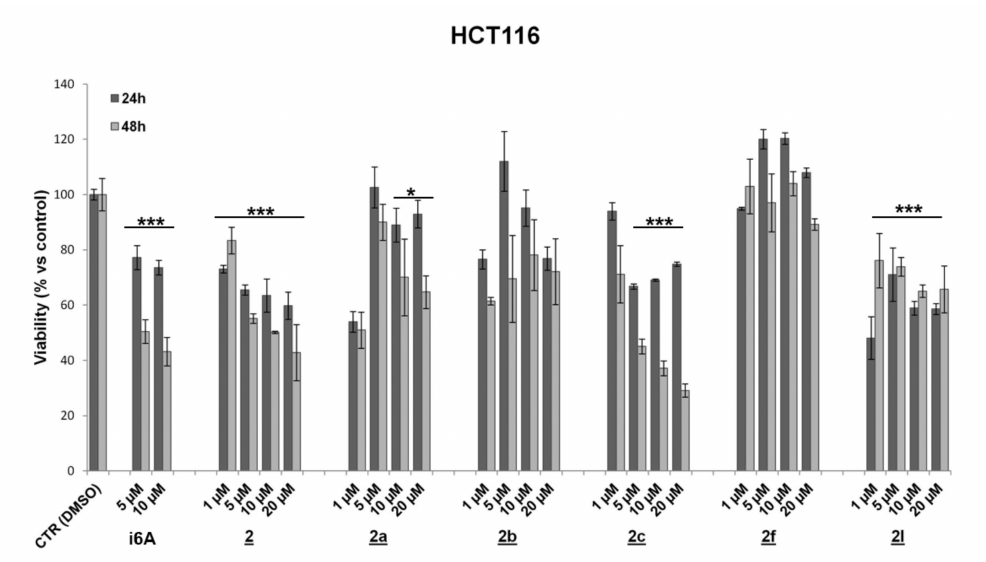
Figure 3. Effect of 2 and its analogues on HCT116 cell viability. Values are means ± SD from three